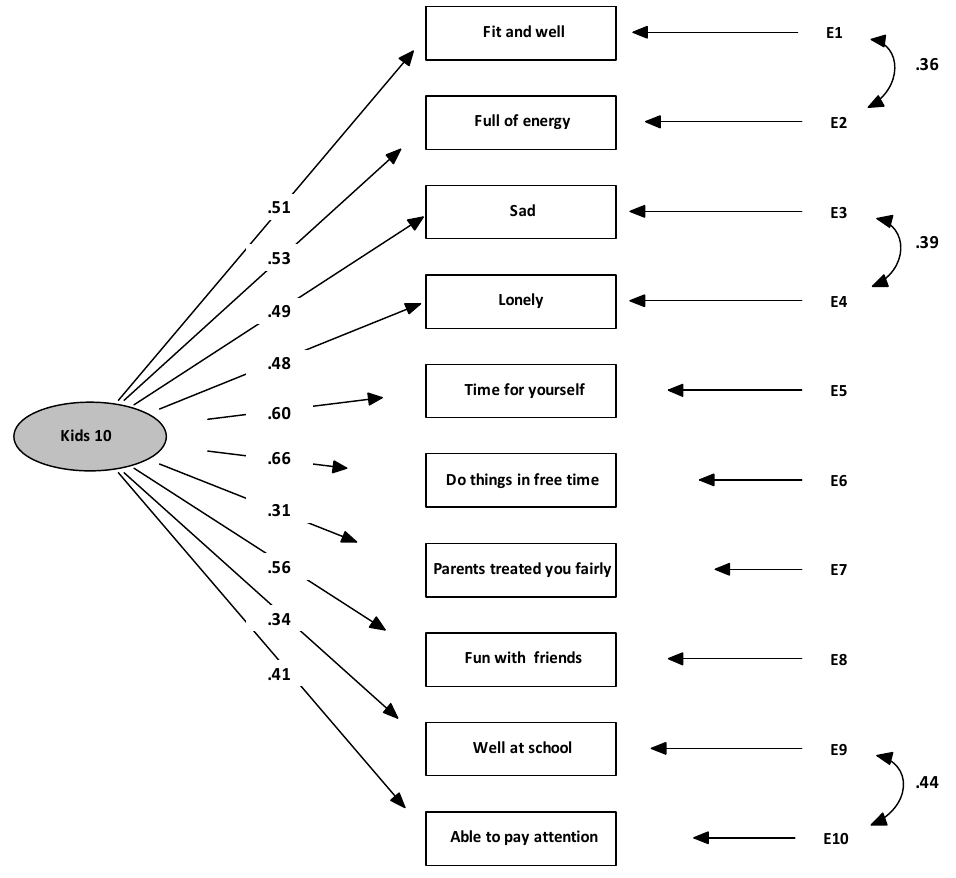
Figure 1. Final model of the Portuguese version of KIDSCREEN-10.